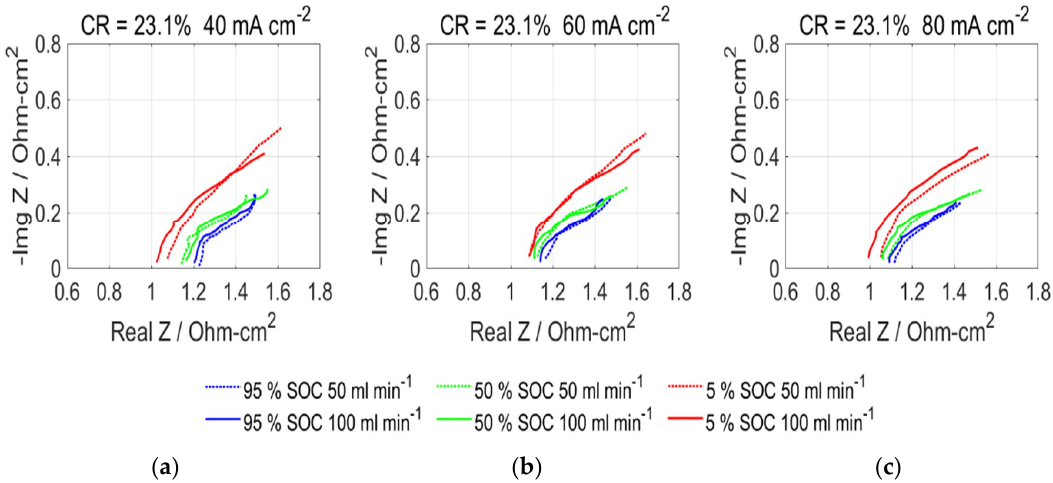
Figure 5. Nyquist plots of EIS of the VRFB under various operating conditions at CR = 23.1%: ( a ) 40 mA cm −2 ; ( b ) 60 mA cm −2 ; ( c ) 80 mA cm −2.